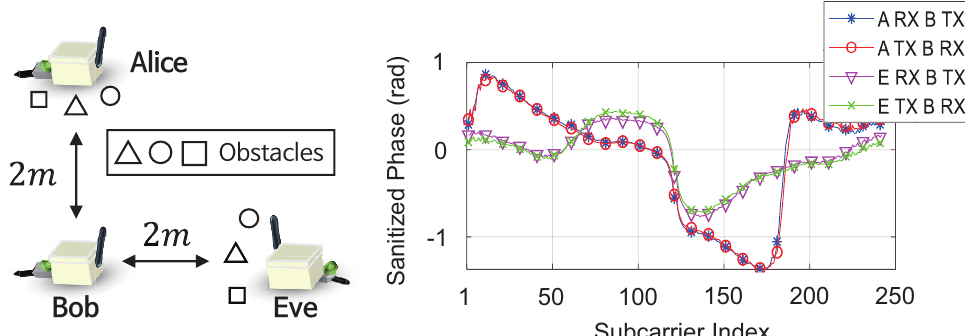
Figure 4. Preliminary test for verifying channel reciprocity of sanitized phase [21].